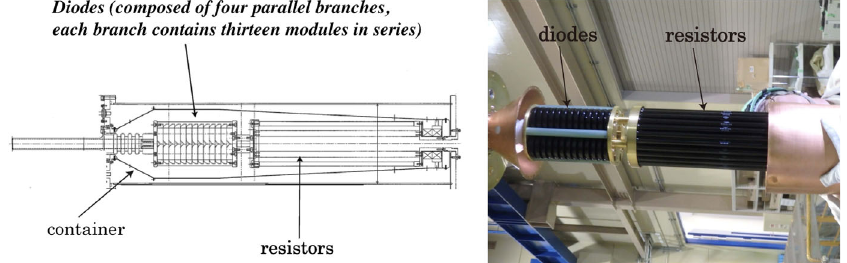
FIG. 6. A detailed schematic (left) of one diode with a 10 Ω resistor from Fig. 5 and its photo (right).